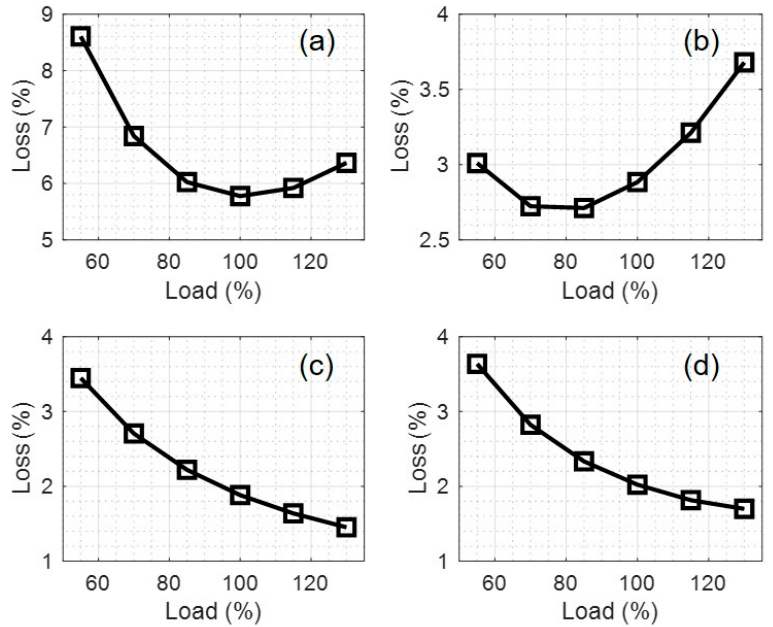
Figure 5. Loss components normalized in percentage under different loads. ( a ) Stator copper loss Rotor bar loss ( c ) Core-loss ( d ) Loss caused by backward magnetic field. ( b ) Rotor bar loss ( c ) Core-loss ( d ) Loss caused by backward magnetic field.